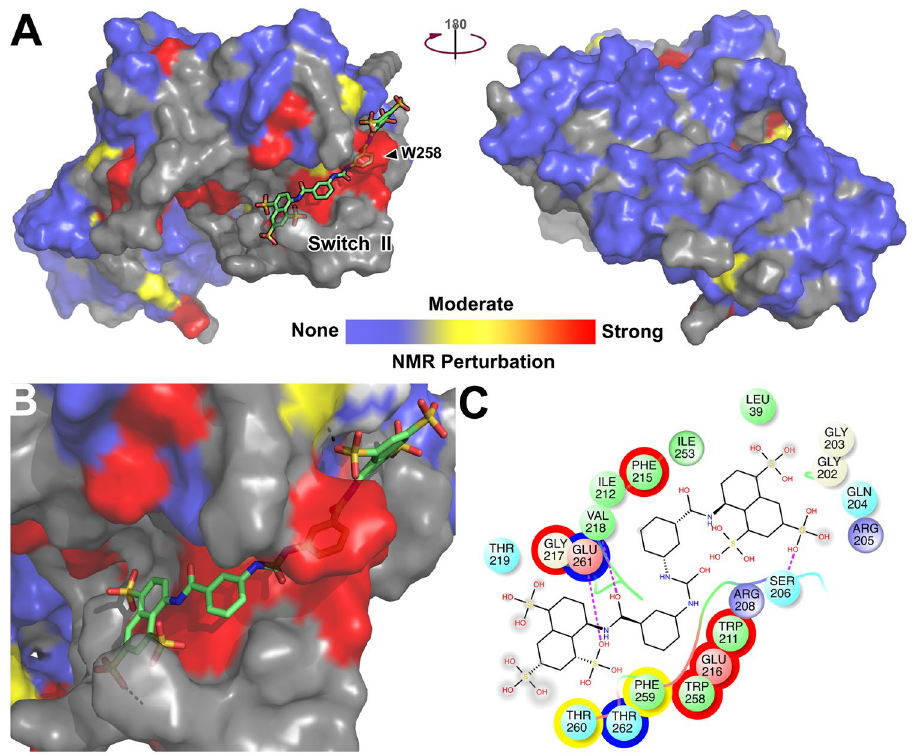
Figure 9. Overlay of NF023-induced NMR perturbations on a structural model of G α i3. ( A,B ) A model of G α i3 in the GIV-bound conformation (Fig. 1) was colored for NMR perturbations as in Fig. 7 in the presence of virtually docked NF023 (balls and sticks). A front and back surface view of G α i3 is shown in ( A ) and an enlarged view of the predicted NF023 binding site in ( B ). (C ) Two-dimensional diagram of NF023 and its predicted binding contacts. Spheres represent all G α i3 residues located at < 4 Å from NF023. The color fill of the spheres indicates the chemical properties of the residues (green = hydrophobic, blue = positively charged, red = negatively charged, cyan = polar, white = neutral). The color of the outer circles indicates the NMR perturbations as in Fig. 7 (no outline = no NMR data available). The diameter of the gray shadows in NF023 indicates solvent exposure of chemical